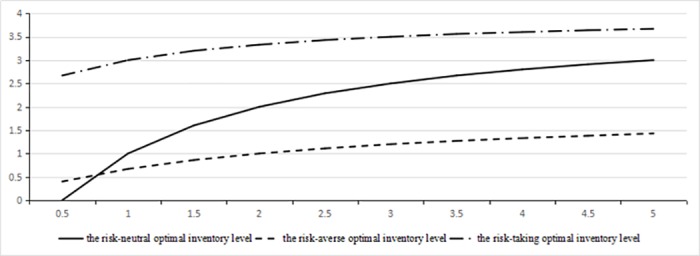
The sensitivity analysis of parameter for shortage cost s.